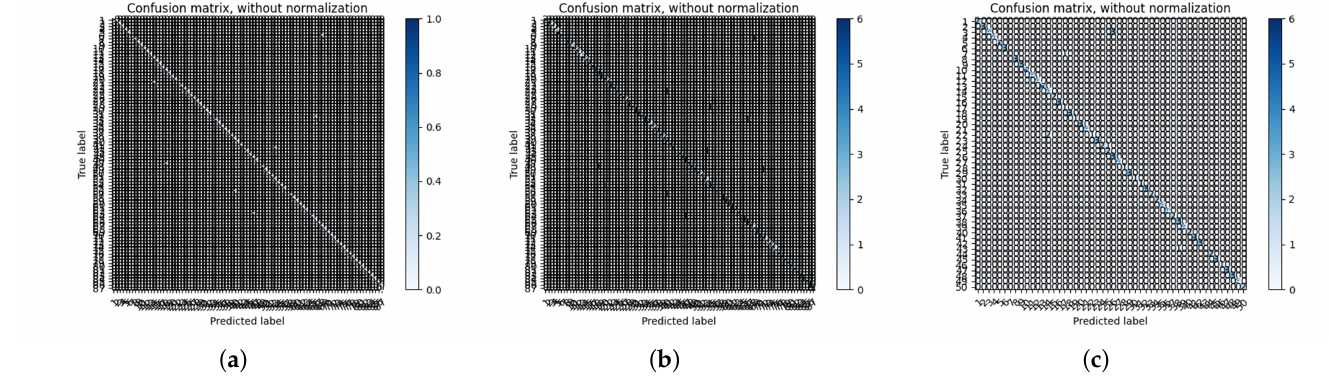
Figure 11. Identification matrix: ( a ) Testing matrix of Group 1 of FRRNet (87 subjects); ( b ) Testing